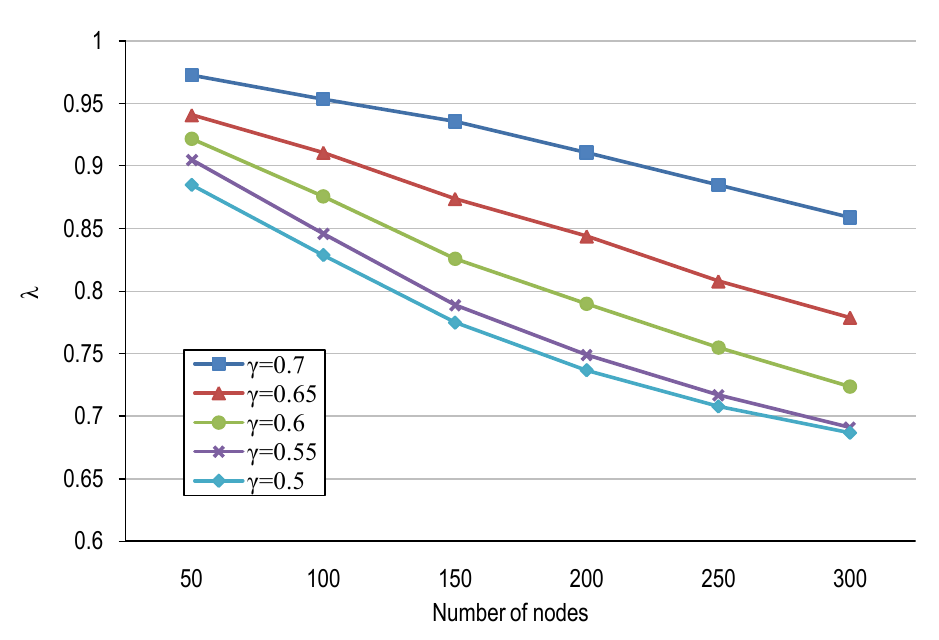
Figure 12. Factor λ in cooperative scheduling for several overlapping